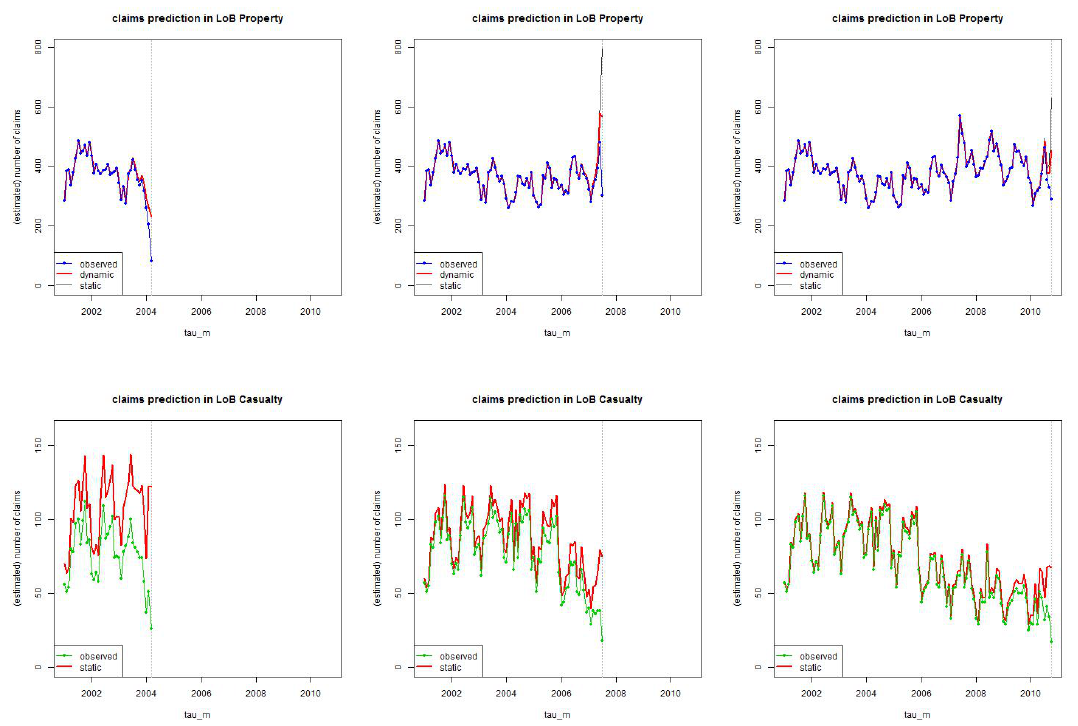
( τ m ) for (top) LoB Property and (bottom) i ( τ m ) ( τ m ) − M ( τ m ) giving the estimated (the spread (cid:98) N i i i